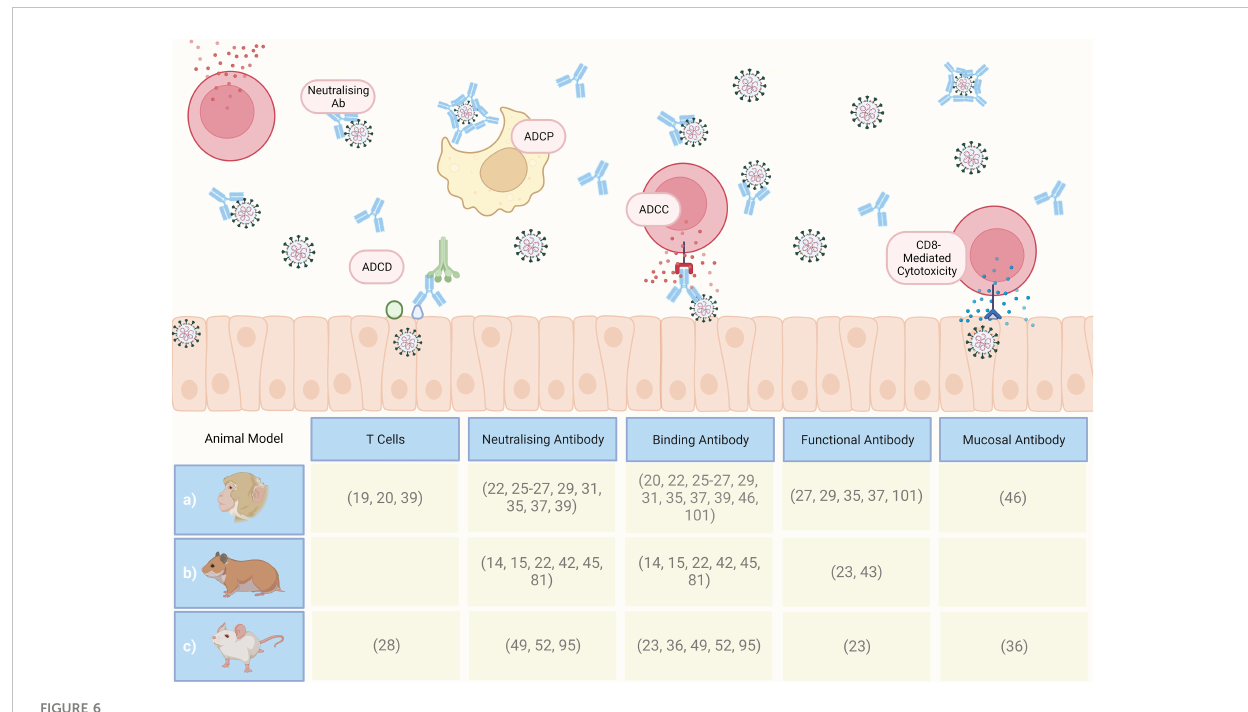
FIGURE 6 Graphical summary of CoPs proposed in the referenced literature following computational analysis of preclinical study datasets, involving a) macaques, b) Syrian golden hamsters, and c) mice. ADCP, antibody-dependent cellular phagocytosis; ADCC, antibody-dependent cellular cytotoxicity; ADCD, antibody-dependent complement; Ab, antibody. Created with